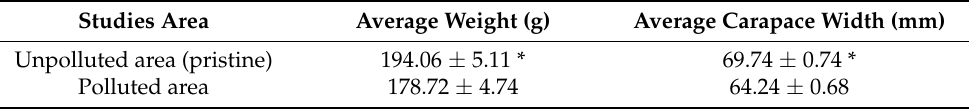
Table 1. Weight (mean ± standard deviation) and width of the carapace (mean ± standard deviation) of animals from unpolluted and polluted areas. The asterisk represents a significant difference between animals from both